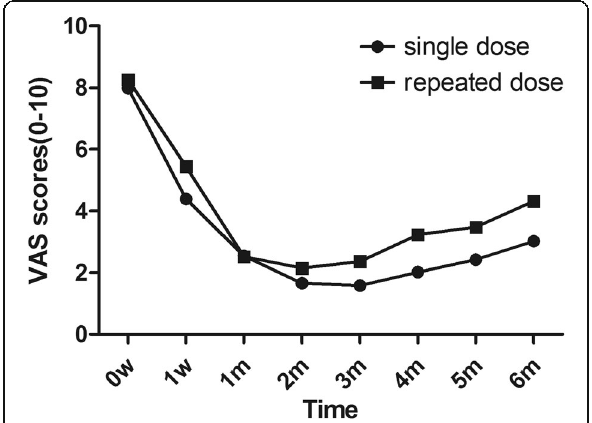
Fig. 1 Monthly VAS scores of TN patients. Patients in the single- and repeated-dose groups were followed for 6 consecutive months after the first BTX-A injection. At each follow-up, the VAS scores of the 2 groups were comparable